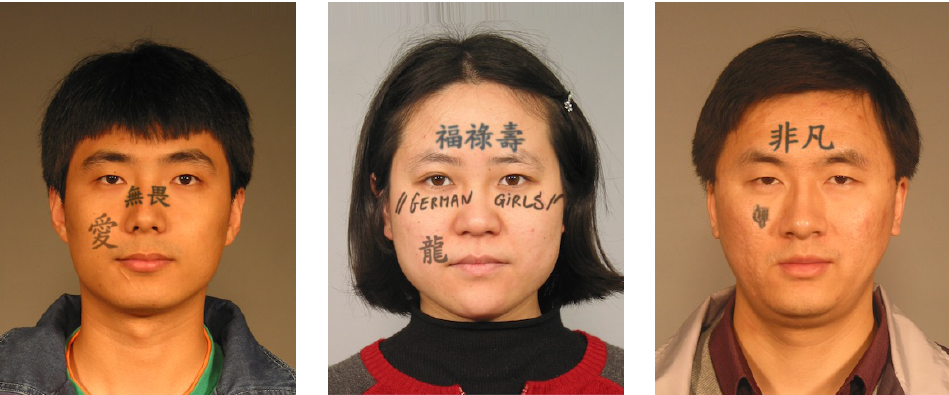
Figure 9. Examples of black tattoos blended to facial